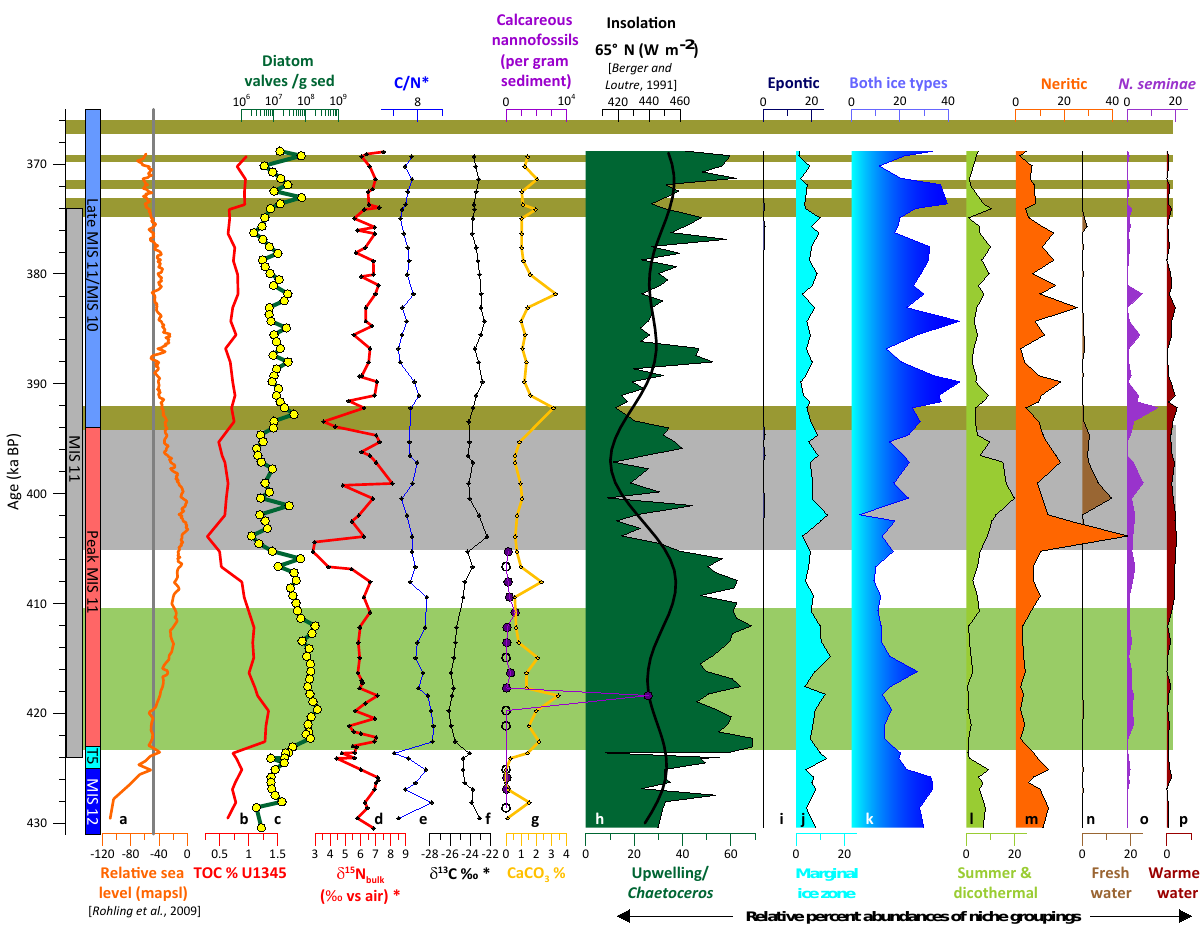
Figure 7. Summary of geochemistry and biological proxies. The grey vertical bar depicts the duration of MIS 11 and colored vertical bars refer to the zones mentioned in the text. (a) Global eustatic sea level (orange) is plotted for reference (Rohling et al., 2010). The sill depth of Bering Strait ( − 50ma.p.s.l.) is shown as a vertical grey line. Total organic carbon ( b , red) is plotted with the total diatom abundance ( c , green line, yellow dots). Geochemical data are plotted as δ 15 N ( d , red), C / N ( e , blue), δ 13 C ( f , black), and %CaCO 3 ( g , yellow). Biological proxies include absolute abundance of calcareous nannofossils ( g , purple). Open circles indicate barren samples; closed circles indicate samples that had calcareous nannofossils present. Relative percent abundances of diatoms are grouped by environmental niche. Chaetoceros RS are green (h) , epontic species are navy blue (i) , marginal ice zone species are light blue (j) , species that fall under both ice categories are shaded with a gradational blue (k) , summer and dicothermal species are light green (l) , neritic species are orange (m) , freshwater species are brown (n) , N. seminae is purple (o) , and warmer water species are maroon (p) . Insolation at 65 ◦ N (black) is overlain on Chaetoceros RS relative percent abundances. Type I laminations are depicted as pale-green bars and type II laminations are depicted as olive-green bars. A grey bar indicates the anomalous